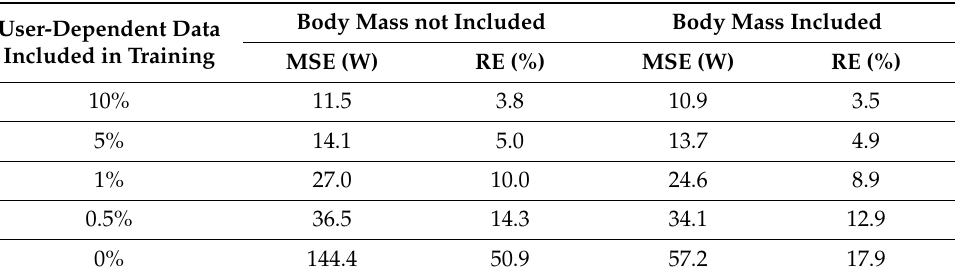
Figure 5. Top: LSTM-based prediction of ski power (watts) for training subjects 1–8 and testing subjects 9–13 where 5% ( top ) and 0.5% ( bottom ) of the data were removed from the testing subject to be used for training.